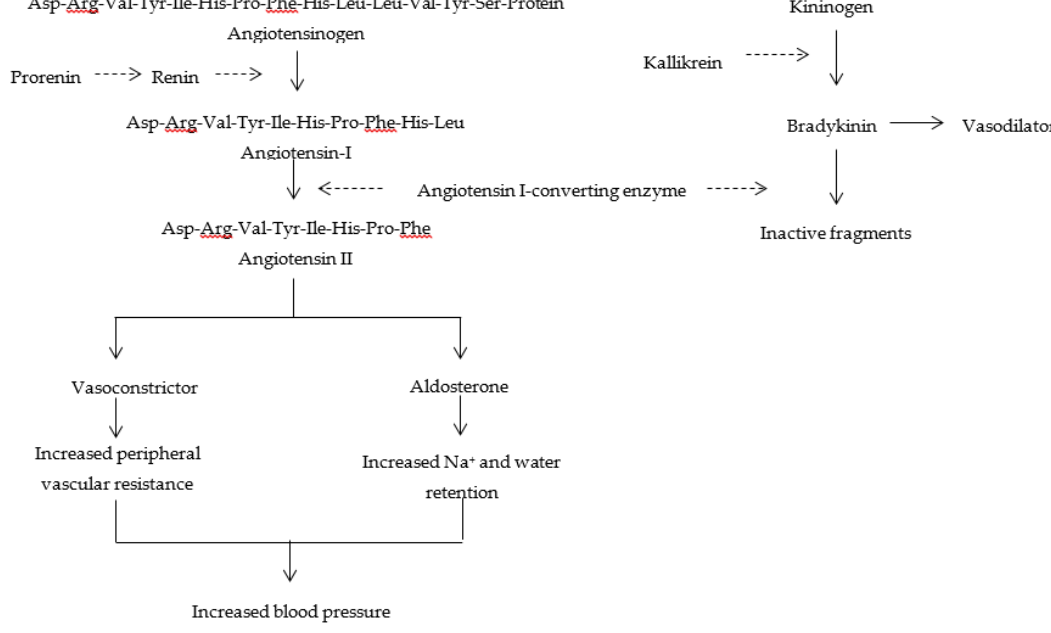
Figure 1. Role of angiotensin I-converting enzyme in the renin angiotensin aldosterone system and the kinin – kallikrein system [15].